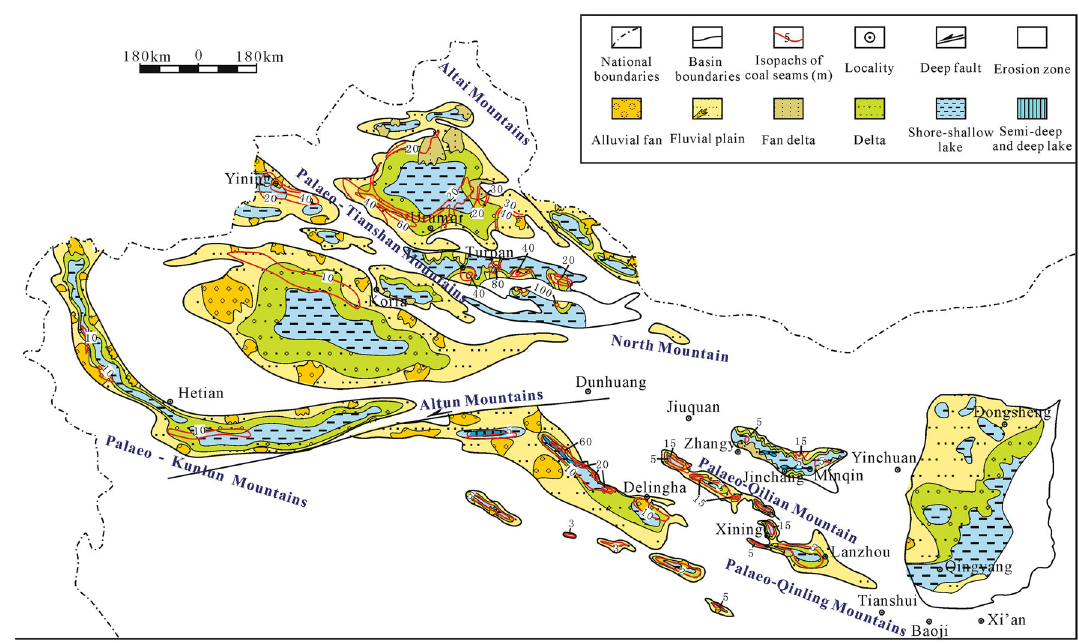
Fig. 14 Paleogeography and distribution of coal seams of SQ3 of the Early-Middle Jurassic in the North China CAA and Northwest